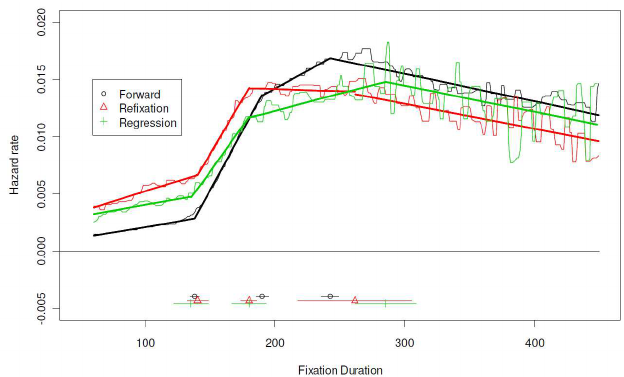
Figure 8. Hazard Functions for Fixations to be Followed by a Forward, Refixation, and Regressive